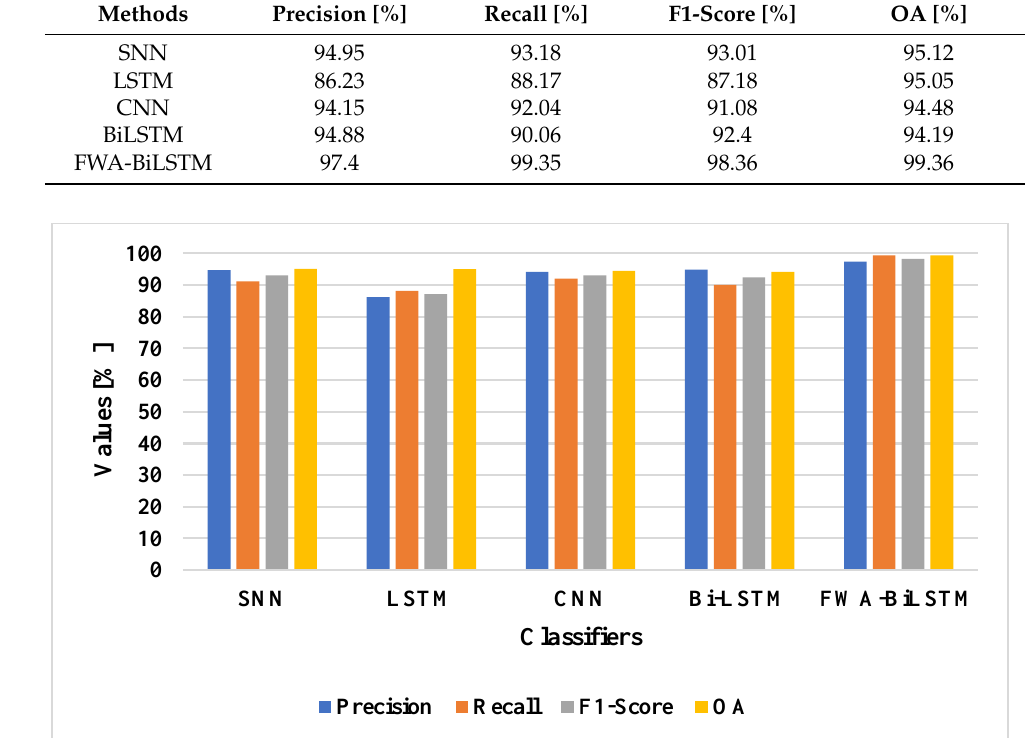
Table 7. Performance of deep learning technique on SVD dataset.